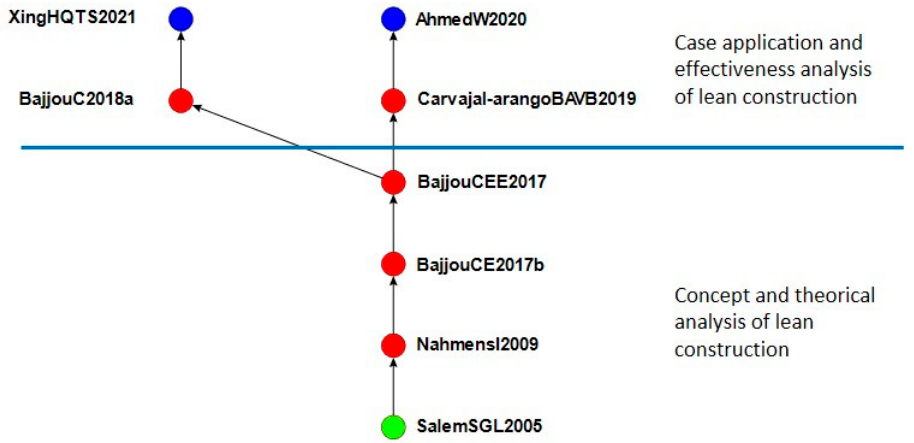
Figure 9. The main path of the fourth